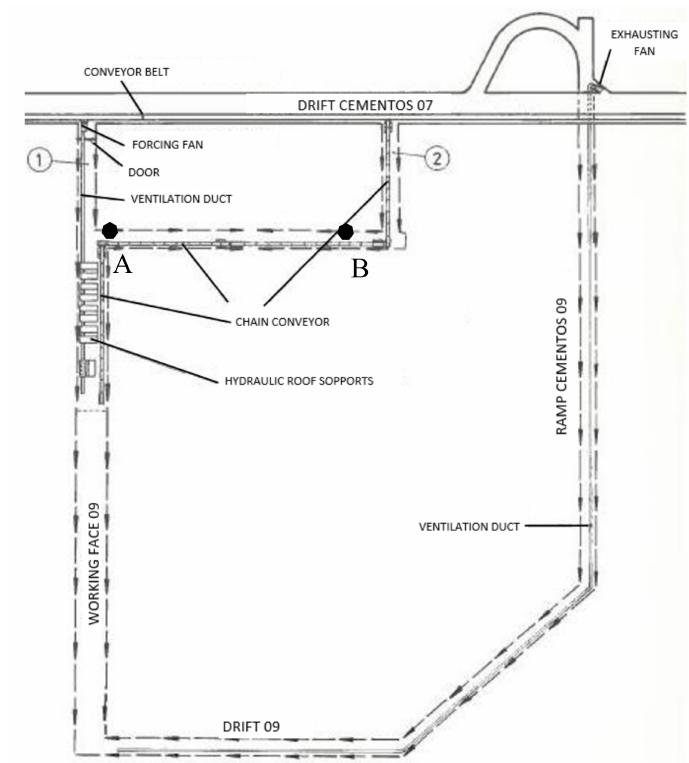
Figure 1. Workshop where the accident occurred. Point 1 and 2 are entry and exist of the working face, respectively, while point A and B are the measuring